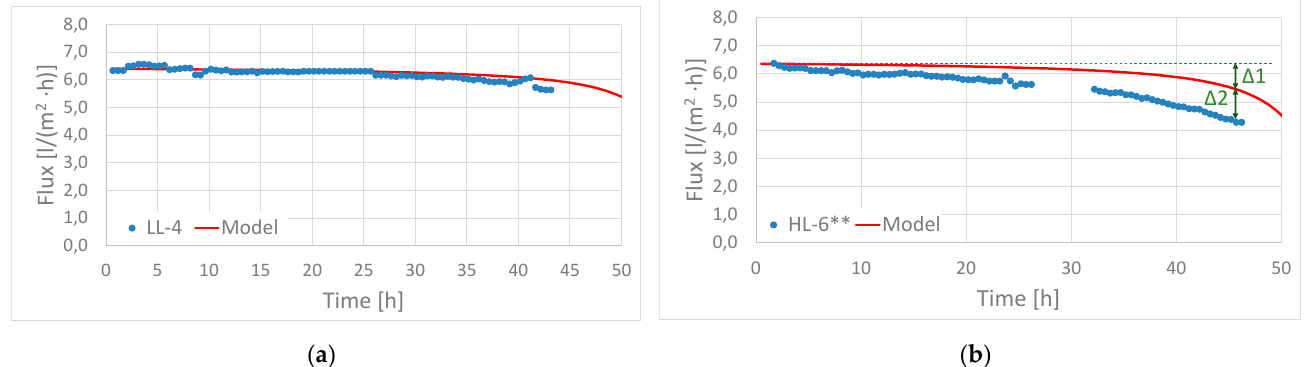
Figure 4 Modelled and measured water fluxes for; ( a ) experiment LL–4 with no membrane fouling and; ( b ) experiment HL-6** with significant membrane fouling.